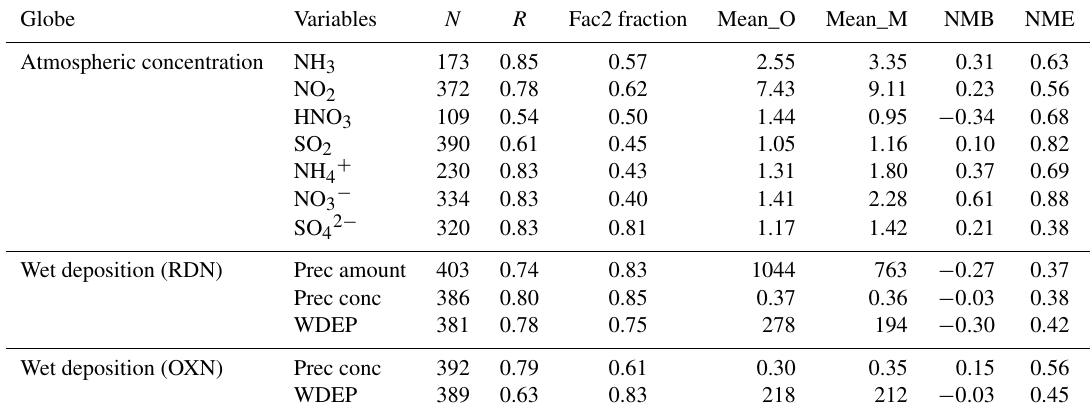
Table 7. Summary statistics of global model evaluation of atmospheric concentrations (µgm − 3 ), annual precipitation (Prec Amount, mm), (RDN) and oxidized N (OXN) in 2015. N is the number of measuring sites. R is Pearson’s correlation coefficient. Fac2 is the fraction of data points that are within a factor of 2. Mean_O and Mean_M of Prec Conc are annual averages of observation and model, respectively. Mean_O and Mean_M of Prec Amount and WDEP are annual totals. NMB is normalized mean bias, NME is normalized mean